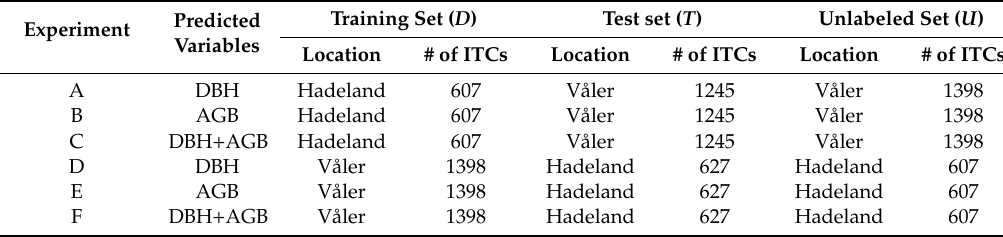
Table 2. Summary of the experiments carried